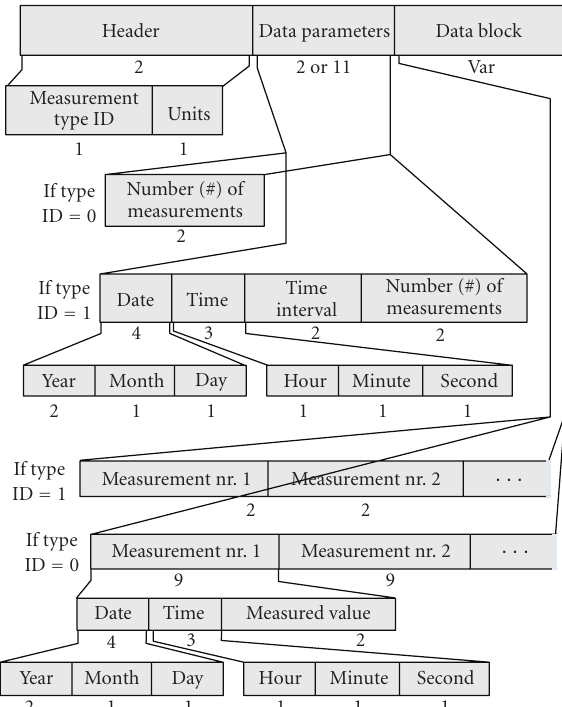
Figure 2: Overview of the data part holding the temperature data (Section-201).